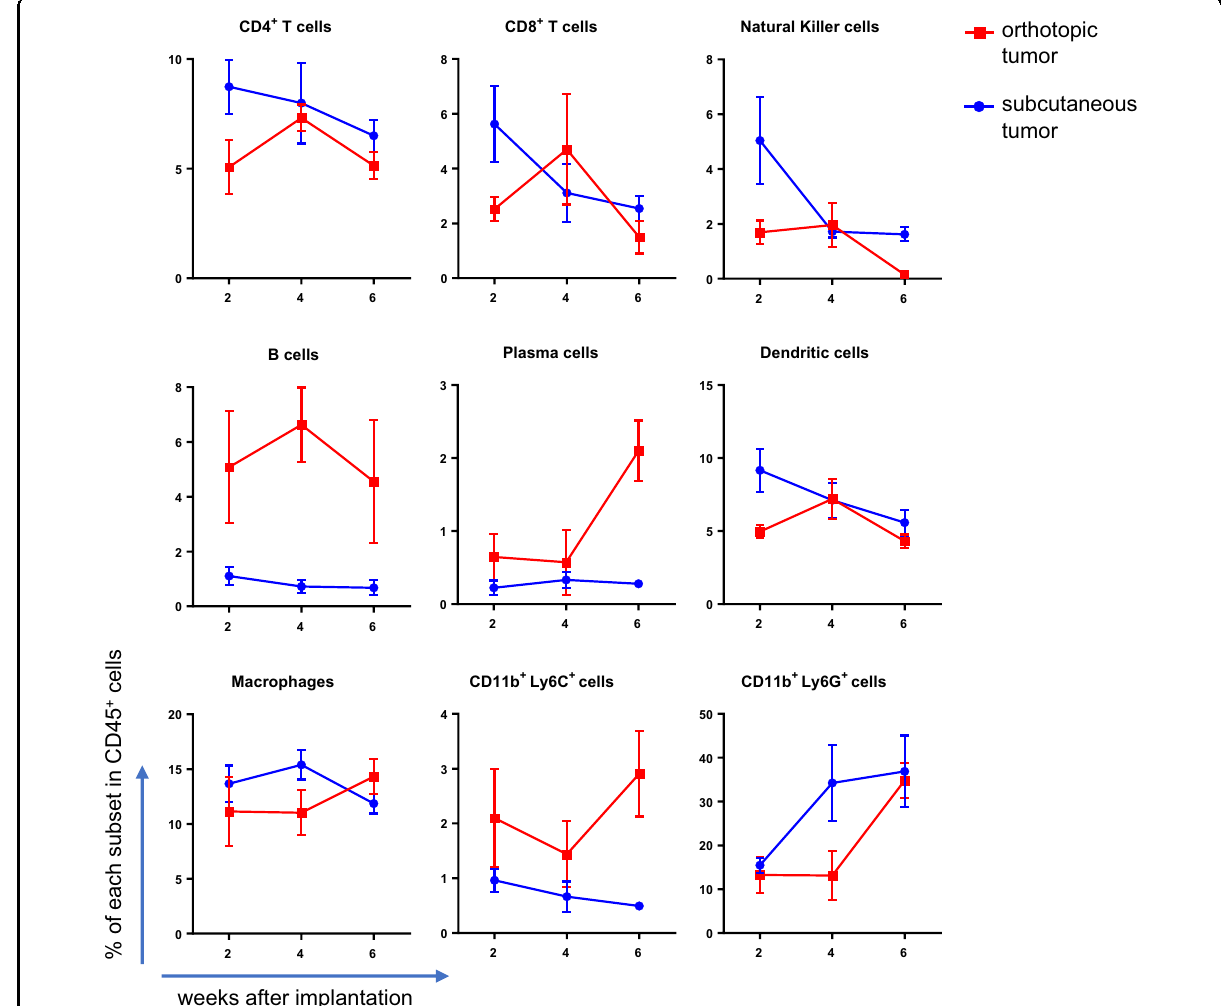
Fig. 5 Time-course pro fi ling of TICs. Flow cytometry analysis of TICs. The proportion of each subset of immune cells to CD45-positive cells is shown. Data were obtained at 2, 4, and 6 weeks after implantation ( n =